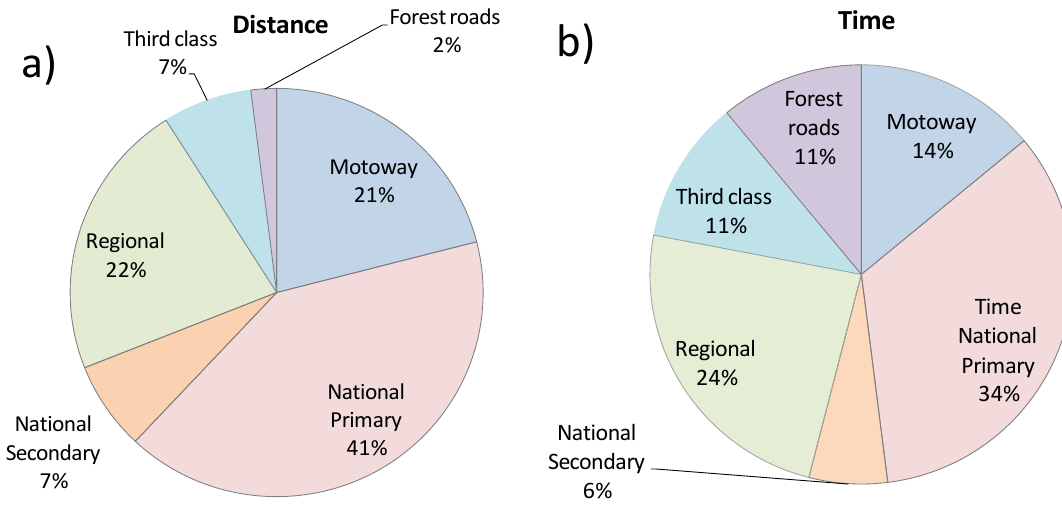
Figure 4. Average ( a ) distance and ( b ) time per road